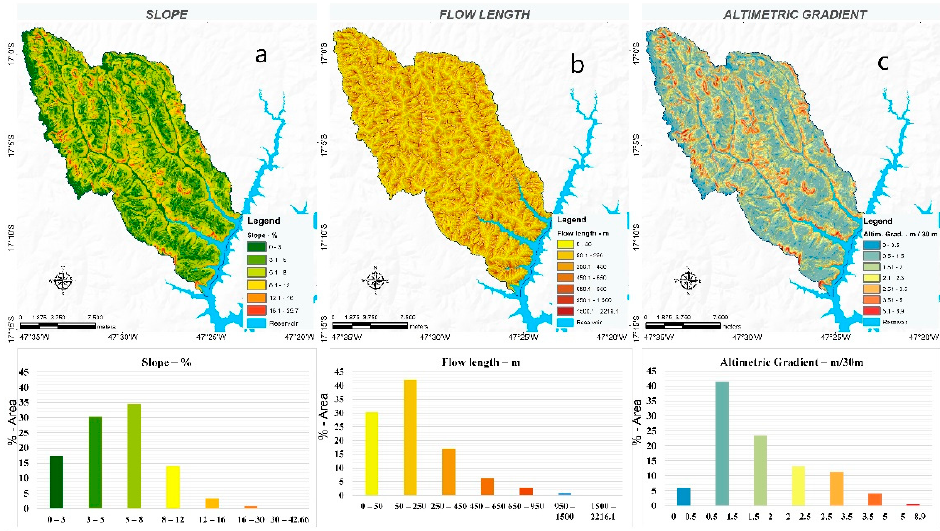
Figure 3. Map of slope ( a ); of flow length ( b ); and altimetric gradient ( c ), considering a standard horizontal distance of 30 m.